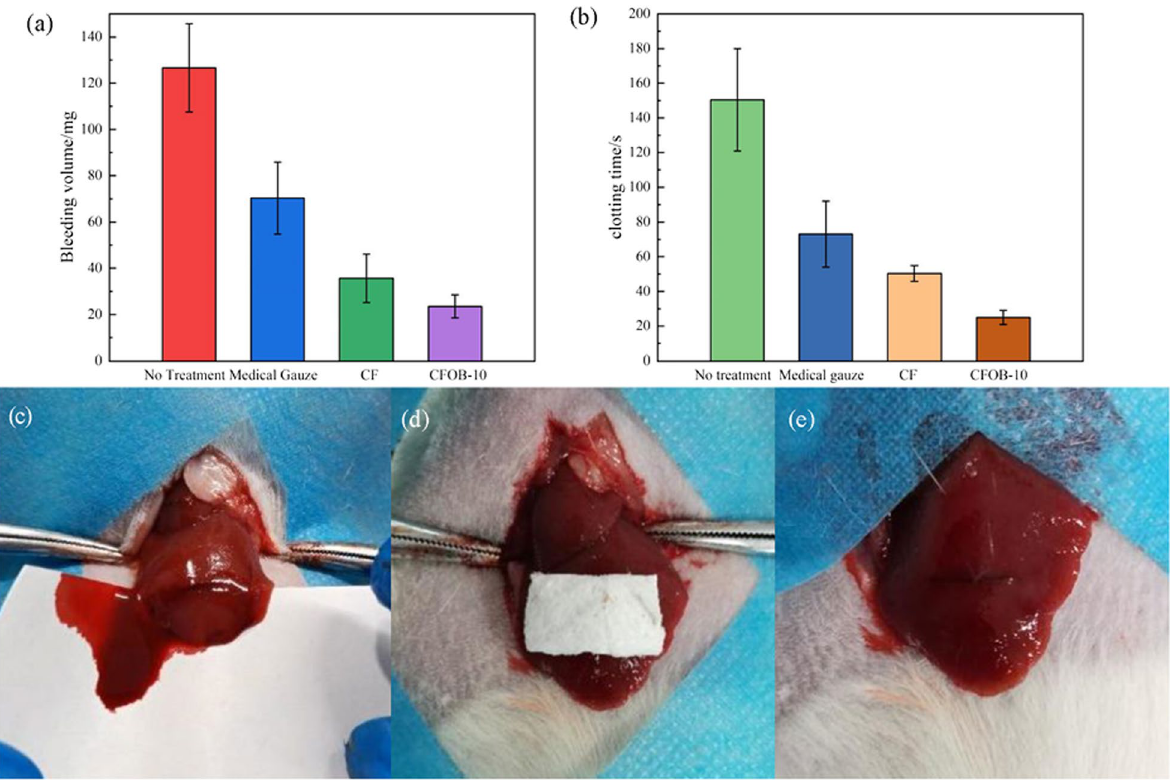
Fig. 8 Comparison of a blood loss and b clotting time in animal experiments with different materials, The comparison of the hemostatic effect of c the blank control group and d and e CFOB at the same time is shown. There was no oozing in the CFOB wound when hemostasis, and the blank group continued to